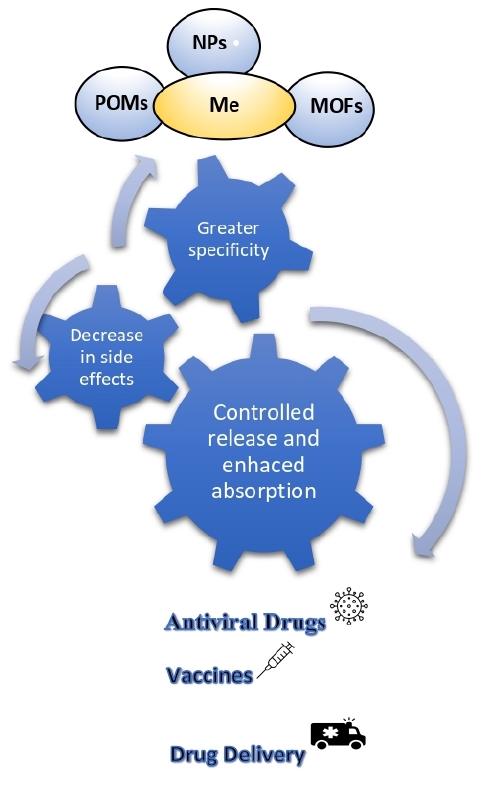
Figure 1. Schematic representation of the main properties and applications of metal-based com- pounds